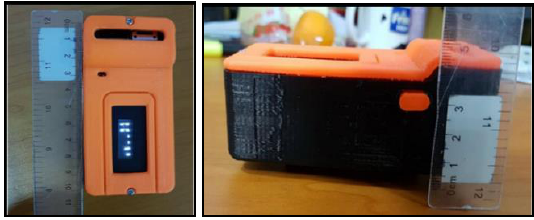
Figure 5. Air quality sensor acquired from CrowdsSense